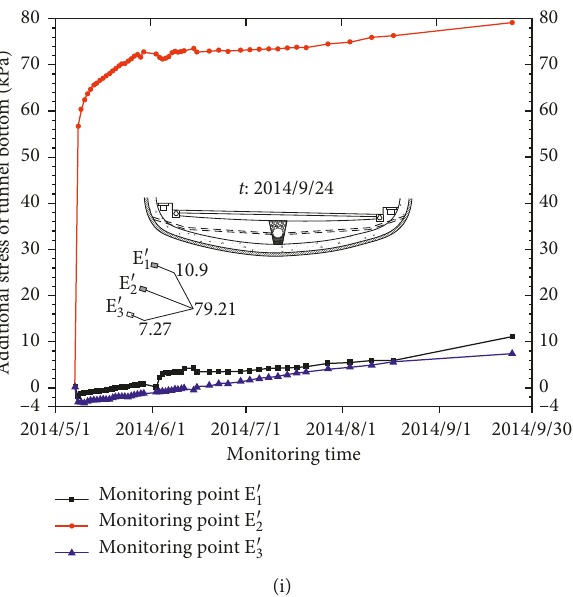
Figure 14: Variation of the additional stress on the tunnel foundation with time. (a) Monitoring point A. (b) Monitoring point B. (c) Monitoring point C. (d) Monitoring point D. (e) Monitoring point E. (f) Monitoring point B